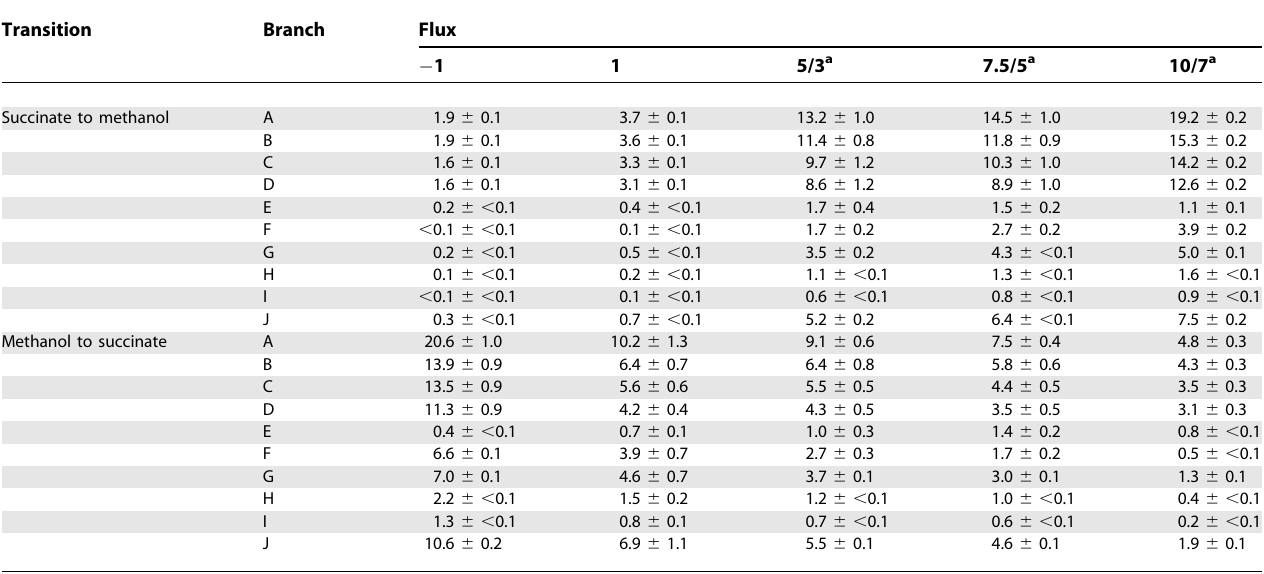
Table 1. Calculated C 1 Fluxes during Transitions between Succinate and Methanol at the Time (h) Relative to the Transition